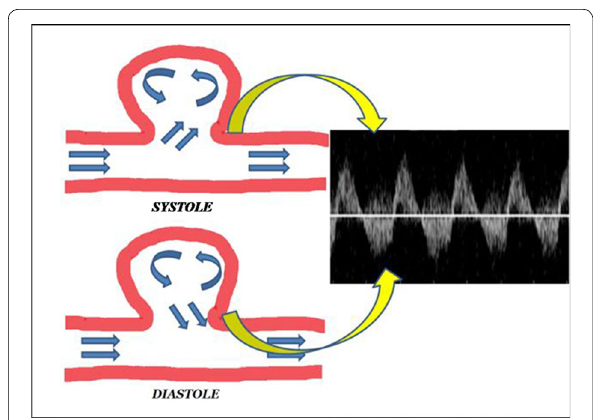
Fig. 14 Schematic representation of the movement of the flow into a pseudoaneurism causing a characteristic biphasic flow in the neck of the PA